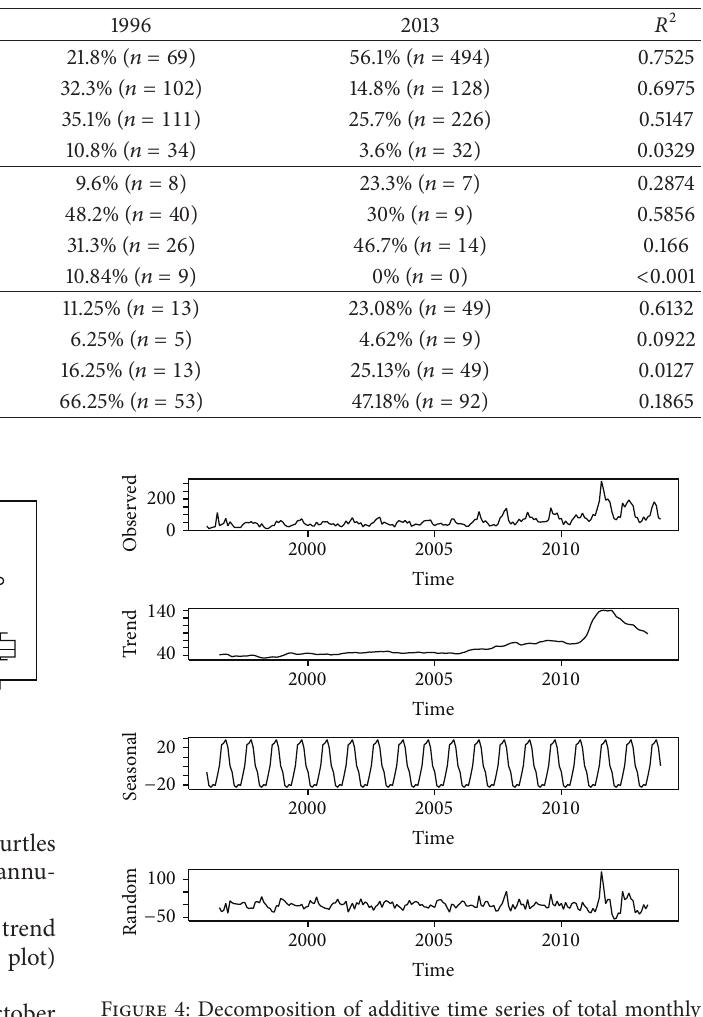
Table 2: Distribution between age classes.